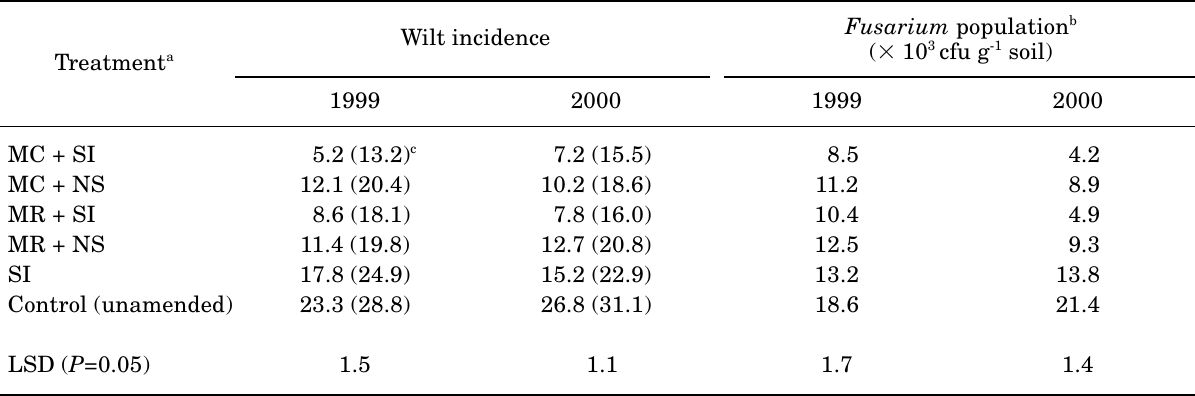
Table 4. Efficacy of cruciferous residues as soil amendment on population of Fusarium oxysporum f. sp . cumini and wilt incidence on